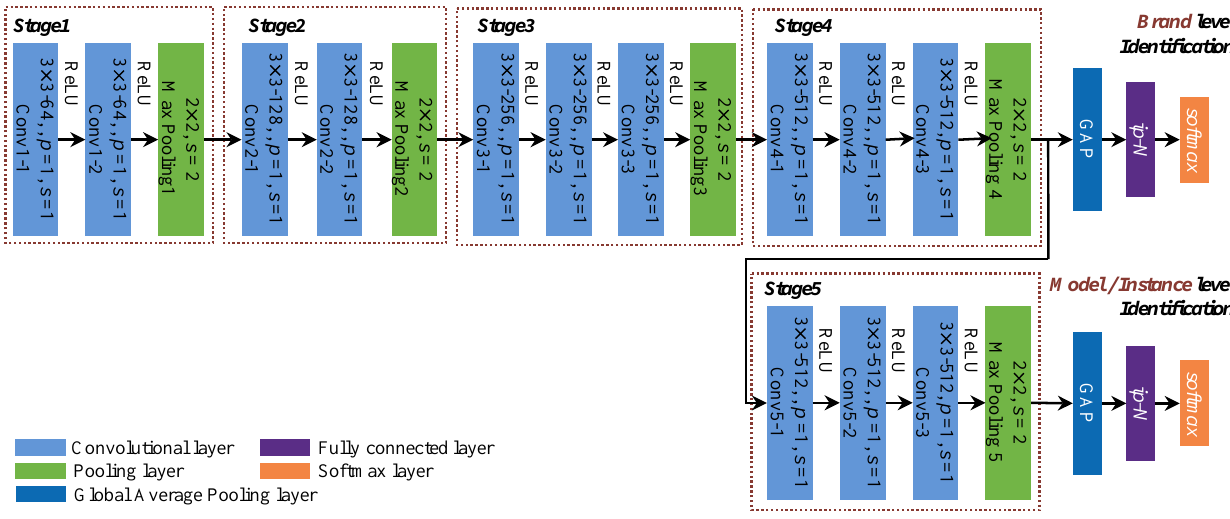
Figure 5. Framework of the proposed source camera identification